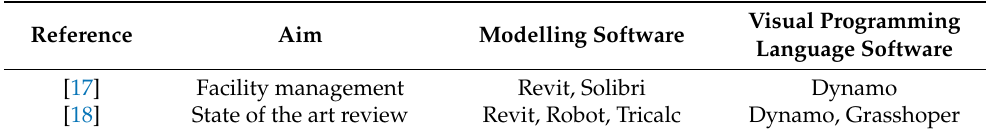
Table 1. Examples of studies using Autodesk software that deal with interoperability